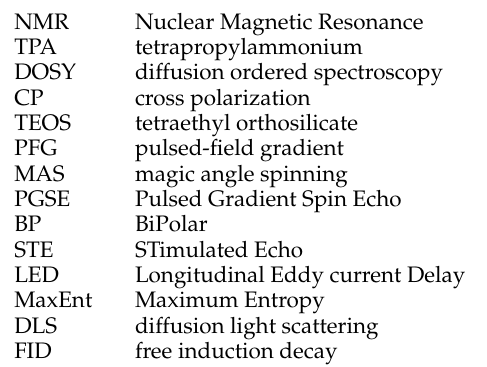
Figure S1: Relaxation delay dependence of 1 H magnetization in T 1 saturation-recovery experiment for the different resonances obtained for TPA, ethanol and water in samples S, S0, SH, SD, and SD0; Figure S2: Relaxation delay dependence of 1 H magnetization in T 2 measurement experiment for the different resonances obtained for TPA, ethanol and water in samples S, S0, SH, SD, and